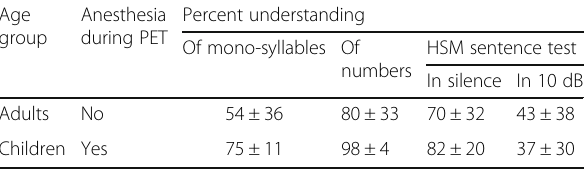
Table 1 Comparison of speech intelligibility 6 years after PET, between patients studied with and without anesthesia. No significant differences were